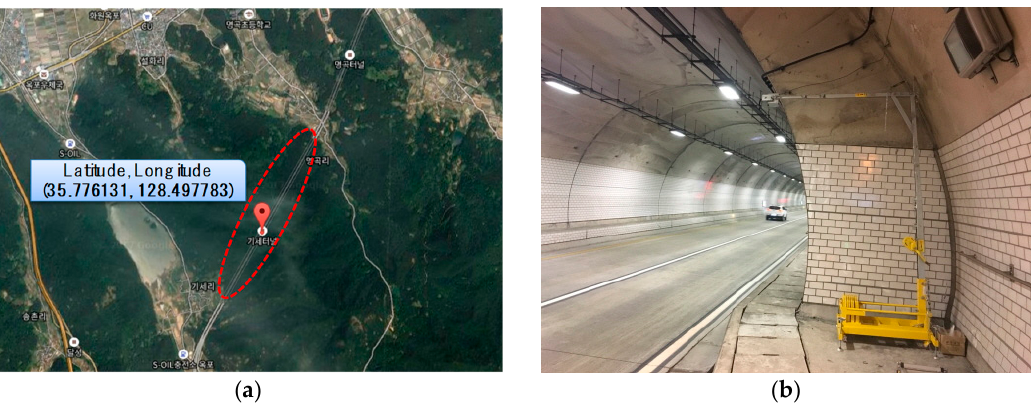
Figure 19. Experiments in urban highway: ( a ) urban highway (2.1 km) in Korea; ( b ) deployment of radar system in highway tunnel.